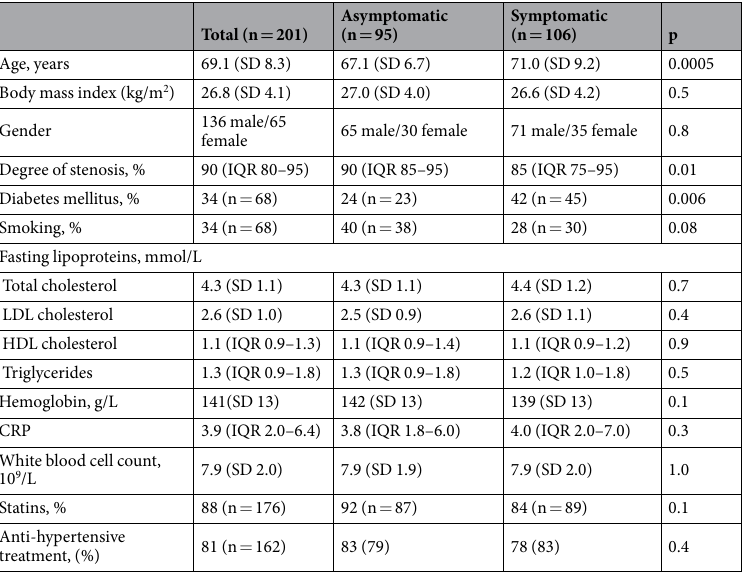
Table 1. Clinical characteristics of the patient cohort. Values are presented as mean and SD, or when not normally distributed as median with interquartile range (IQR). p represents the significance comparing the symptomatic and asymptomatic patient groups. CRP, C-reactive